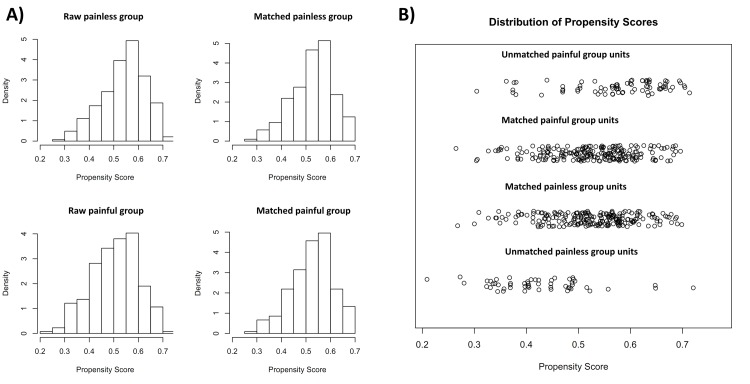
(A) Histogram for propensity-score matching. (B) Jitter plots for propensity-score matching.